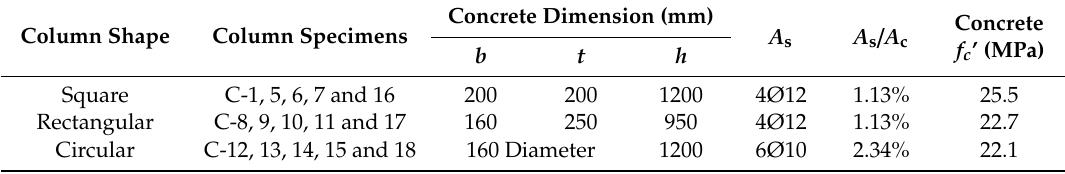
Figure 1. Geometric details of the RC columns.